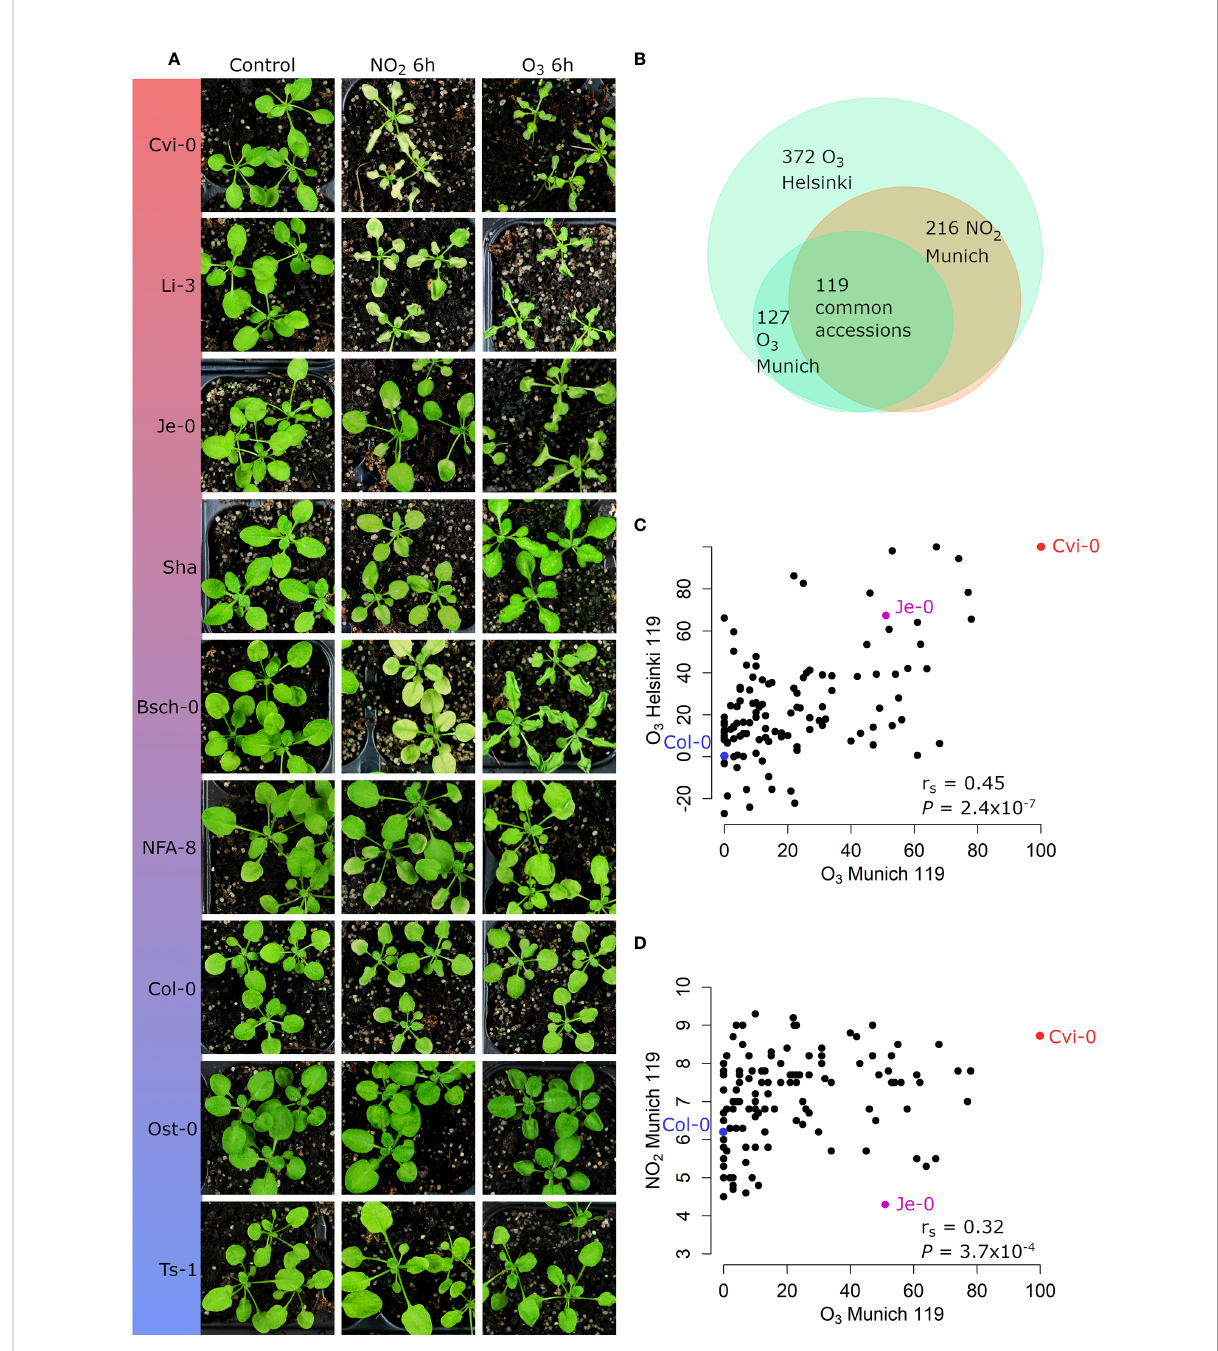
FIGURE 3 O 3 injury and NO 2 injury phenotypes of different accessions. (A) Images of clean air control, 6h of 10 ppm of NO 2 treated and 6h of 350 ppb O 3 treated accessions in Munich. (B) Overlap of accessions used in the different O 3 and NO 2 treatments. (C) O 3 injury phenotypes (percentage of damaged leaves relative to Col-0) in Munich of the 119 common accessions are plotted against O 3 injury phenotypes in Helsinki. (D) NO 2 injury phenotypes (cumulative score) are plotted against O 3 injury phenotypes in Munich. The O 3 phenotypes are from two biological repeats of O 3 fumigations (350 ppm, 6h), with 5 plants (Munich) or 8 plants (Helsinki) per accession (see Supplementary Table S7 for the scores for each accession). O 3 sensitivity was quanti fi ed as O 3 ‐ induced visible leaf injury (number of leaves with damage/total leaves, displayed as percentages and normalized to Col-0). The NO 2 phenotypes are visible injury scores from three fumigations (10, 20 and 30 ppm) with 3 plants per accession. The cumulative score is on a scale from 3 to 15. Spearman ’ s correlation coef fi cients (r s ) are presented on the bottom right corner (C, D) . The accessions Col-0 and Cvi-0, which were included in all treatments and repeats, are highlighted in blue and red,